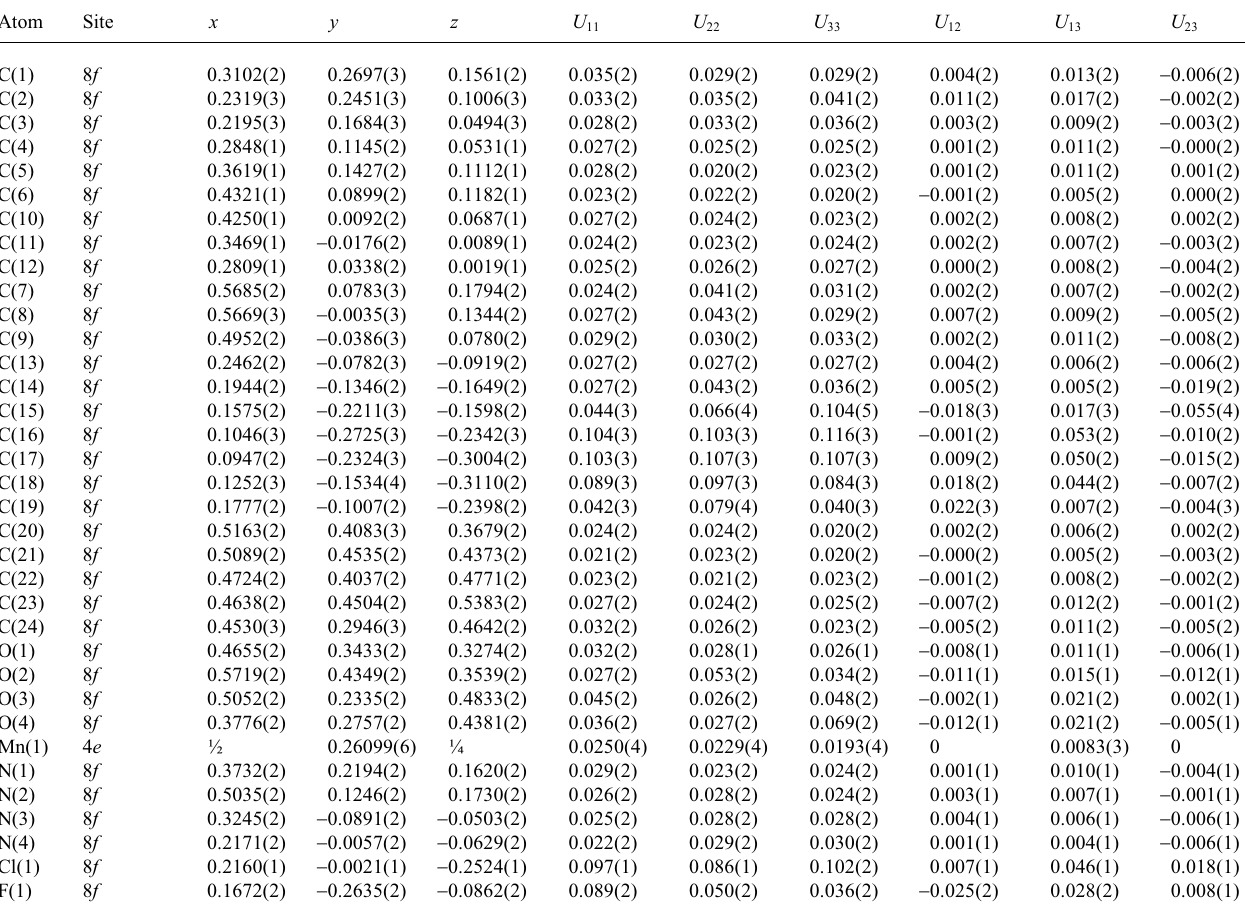
Table 3. Atomic coordinates and displacement parameters (in Å 2